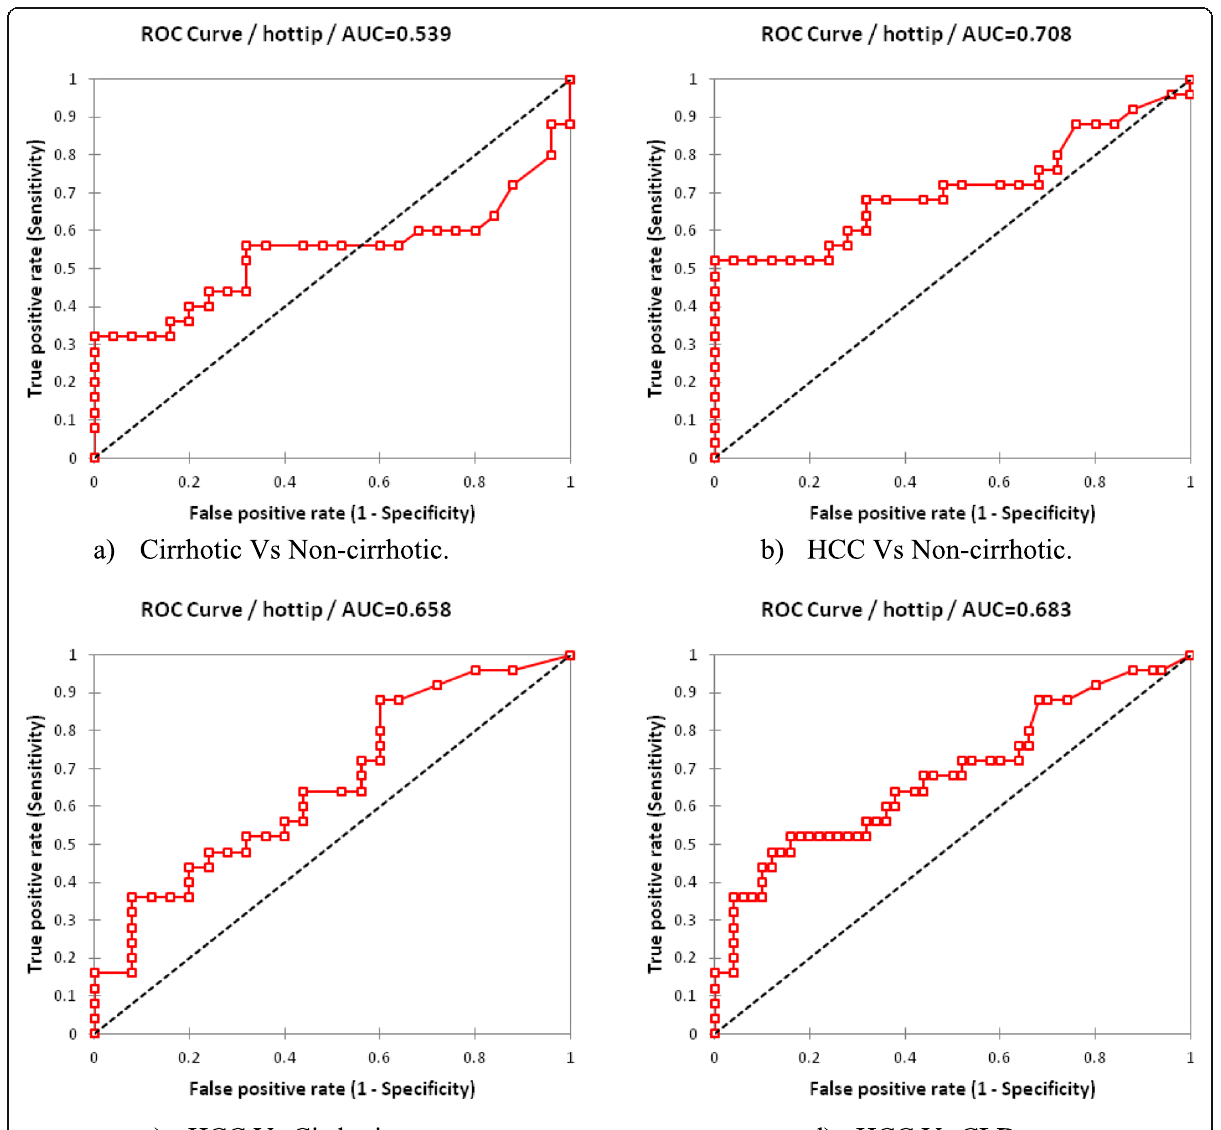
Fig. 7 ROC curve of HOTTIP in the studied